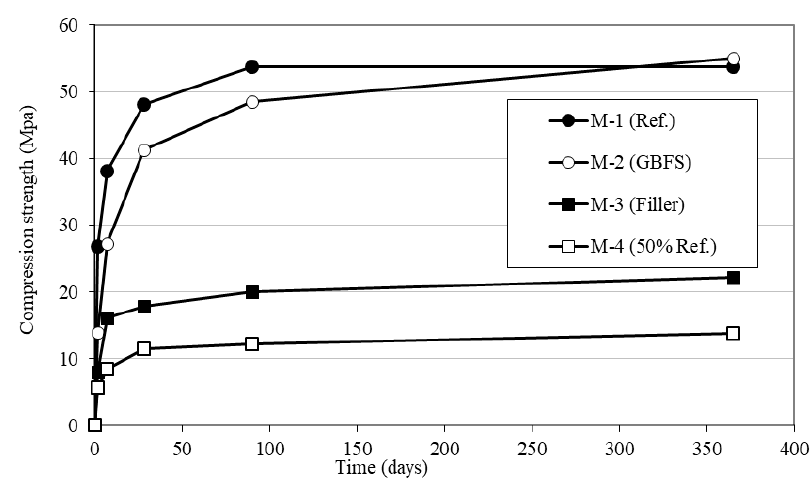
Materials 2019 , 12 , x FOR PEER REVIEW Figure 5. Compressive strength of the mortars (2, 7, 28, 90 and 365 days). Figure 5. Compressive strength of the mortars (2, 7, 28, 90 and 365 days).